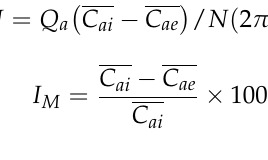
2 absorption membrane